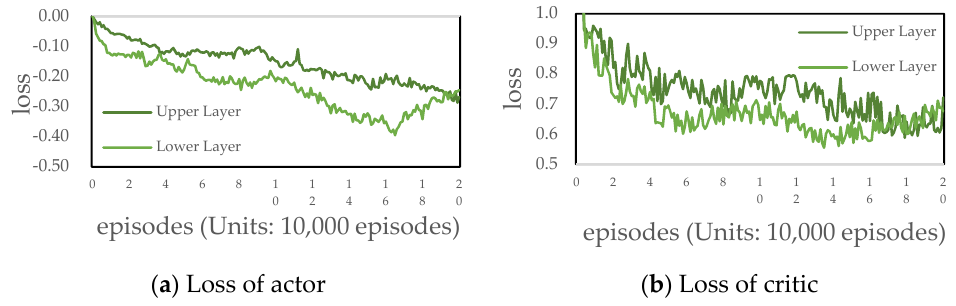
Figure 8. Change of loss depending on the number of learning using the double layered A3C: ( a ) loss of actor and ( b ) loss of critic. The x -axis is number of episodes (units: 10,000 episodes) and the y -axis is loss.